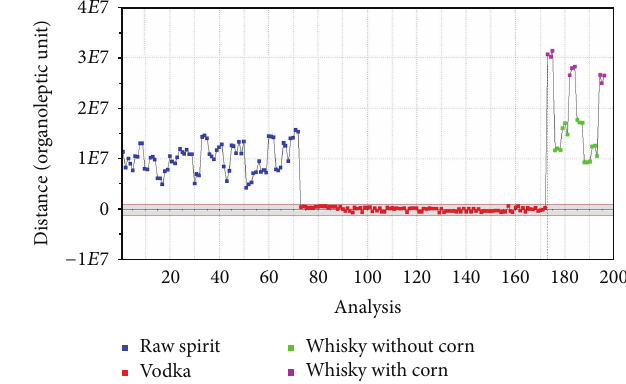
Figure 9: SQC analysis for unflavoured vodkas, raw spirits, and whiskies: vodka, reference